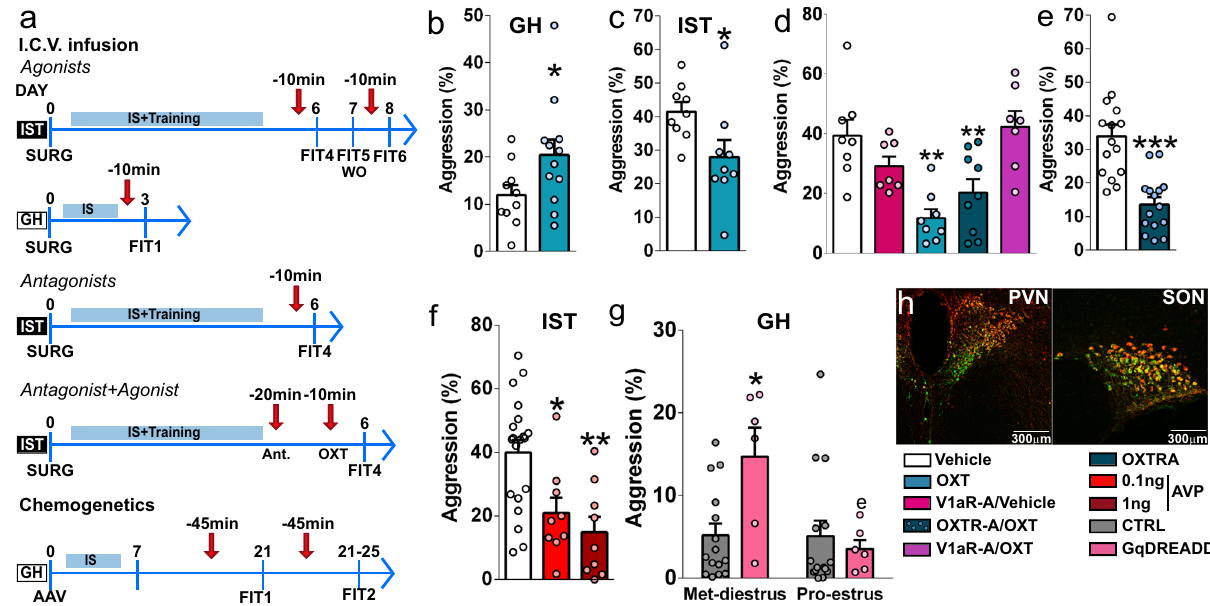
Fig. 3 Endogenous OXT promotes, whereas synthetic AVP and OXT reduce aggression in females. a Experimental design for pharmacological and chemogenetic experiments targeting the OXT and AVP systems in isolated and trained (IST) and group-housed (GH) rats. ( AAV adeno-associated DREADD virus infusion into the hypothalamic paraventricular (PVN) and supraoptic (SON) nuclei; AVP arginine vasopressin; arrow = drug infusions; FIT female intruder test, IS social isolation, OXT oxytocin, OXTR-A OXT receptor antagonist, SURG surgery, V1aR-A V1a receptor antagonist, WO wash-out). b i.c.v. infusion of OXT (50 ng/5 µ l) increased aggression in GH (two-tailed Student ’ s t test t (19) = 2.46, p = 0.024), c but decreased aggression in IST females ( t (8) = 2.33, p = 0.048, data corresponds to FIT4 and 6). d i.c.v. infusion of V1aR-A (750 ng/5 µ l), but not OXTR-A (750 ng/5 µ l), blocked the anti-aggressive effects of OXT in IST females (one-way ANOVA followed by Bonferroni F (3,28) = 10.1, p = 0.001). Also, the V1aR-A alone did not affect aggression. Both, e i.c.v. infusion of OXTR-A ( t (28) = 4.96, p < 0.0001) and f i.c.v. AVP (0.1 or 1 ng/5 µ l) reduced total aggressive behavior ( F (3,54) = 7.48, p = 0.0003) in IST rats. g Chemogenetic activation of OXT neurons in the PVN and SON increased aggression only in metestrus-diestrus GH rats (two-way ANOVA, factor treatment: F (1,19) = 3.342, p = 0.083; estrous cycle: F (1,19) = 6.68, p = 0.018; treatment × estrous cycle: F (1,19) = 6.45, p = 0.02). h Con fi rmation of virus infection in the PVN (right) and SON (left). OXT-neurophysin I staining: green; mCherry (virus): red. Scale bars 300 µ m.